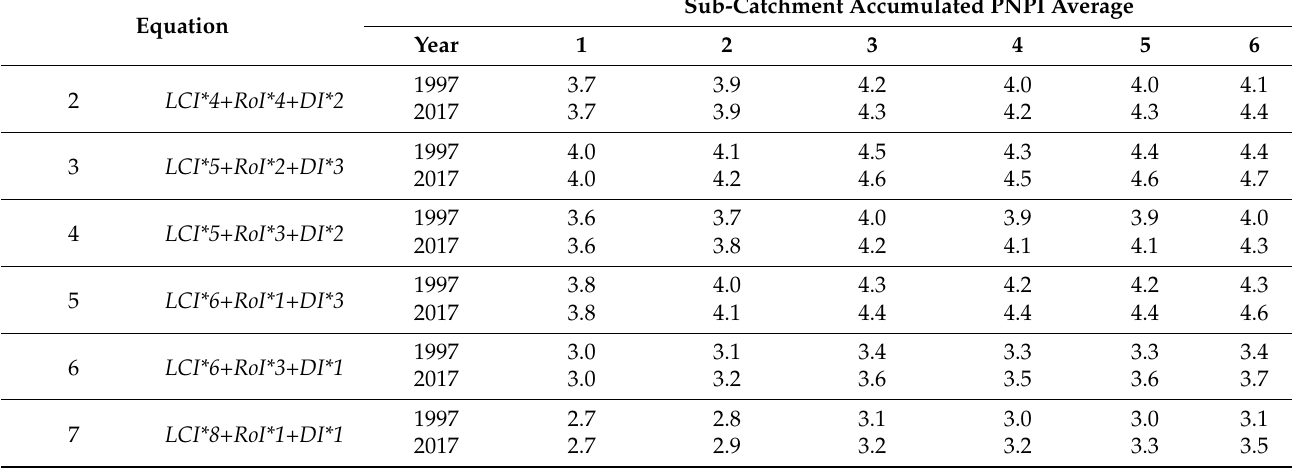
Table 8. Accumulated mean non-point pollution index (PNPI), calculated with Equations (2)–(7), for sub-catchments 1–6 in 1997 and 2017.